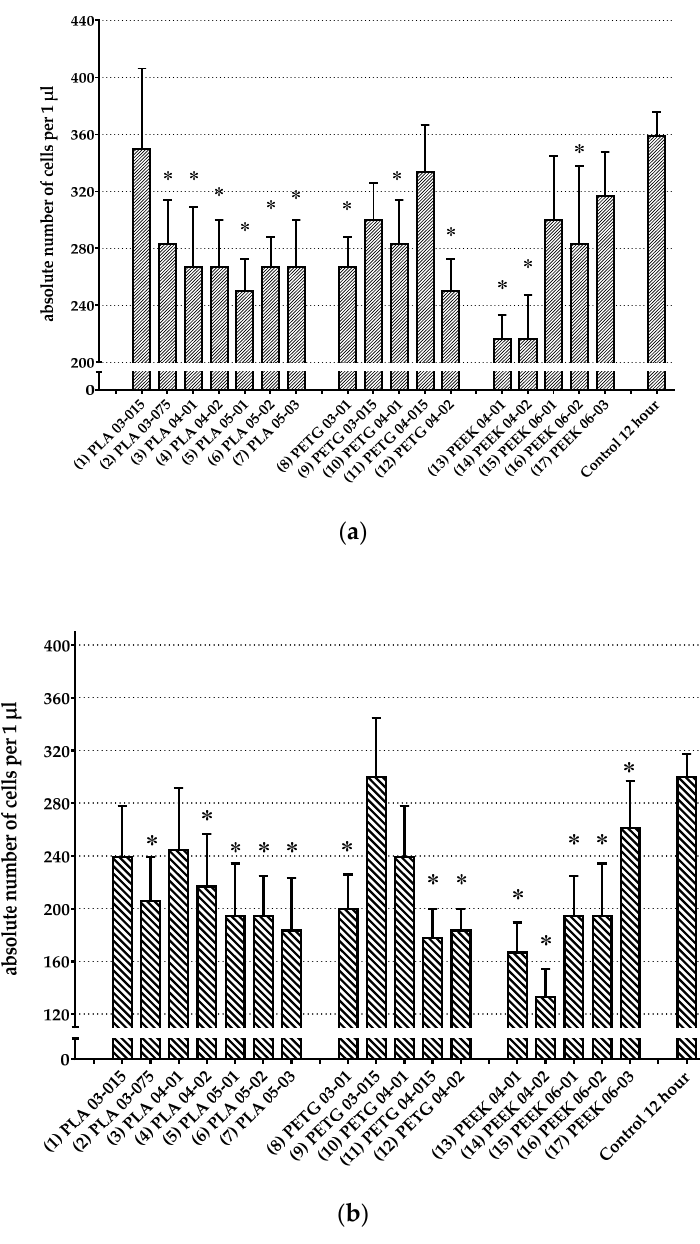
Figure 6. Absolute cell count of bone marrow ( a ) and peritoneal lavage ( b ) after 12-h exposure to culture with polymer samples. * p < 0.05 in relation to the control group without polymer sample according to the generalized linear model (GLM) one-way repeated measures ANOVA post-hoc Duncan’s